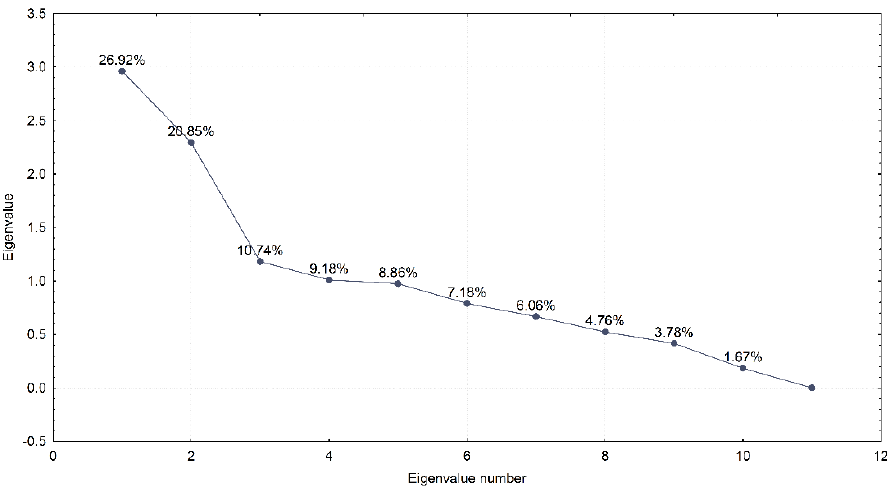
Figure 15. Principal components (adopted from [13]).